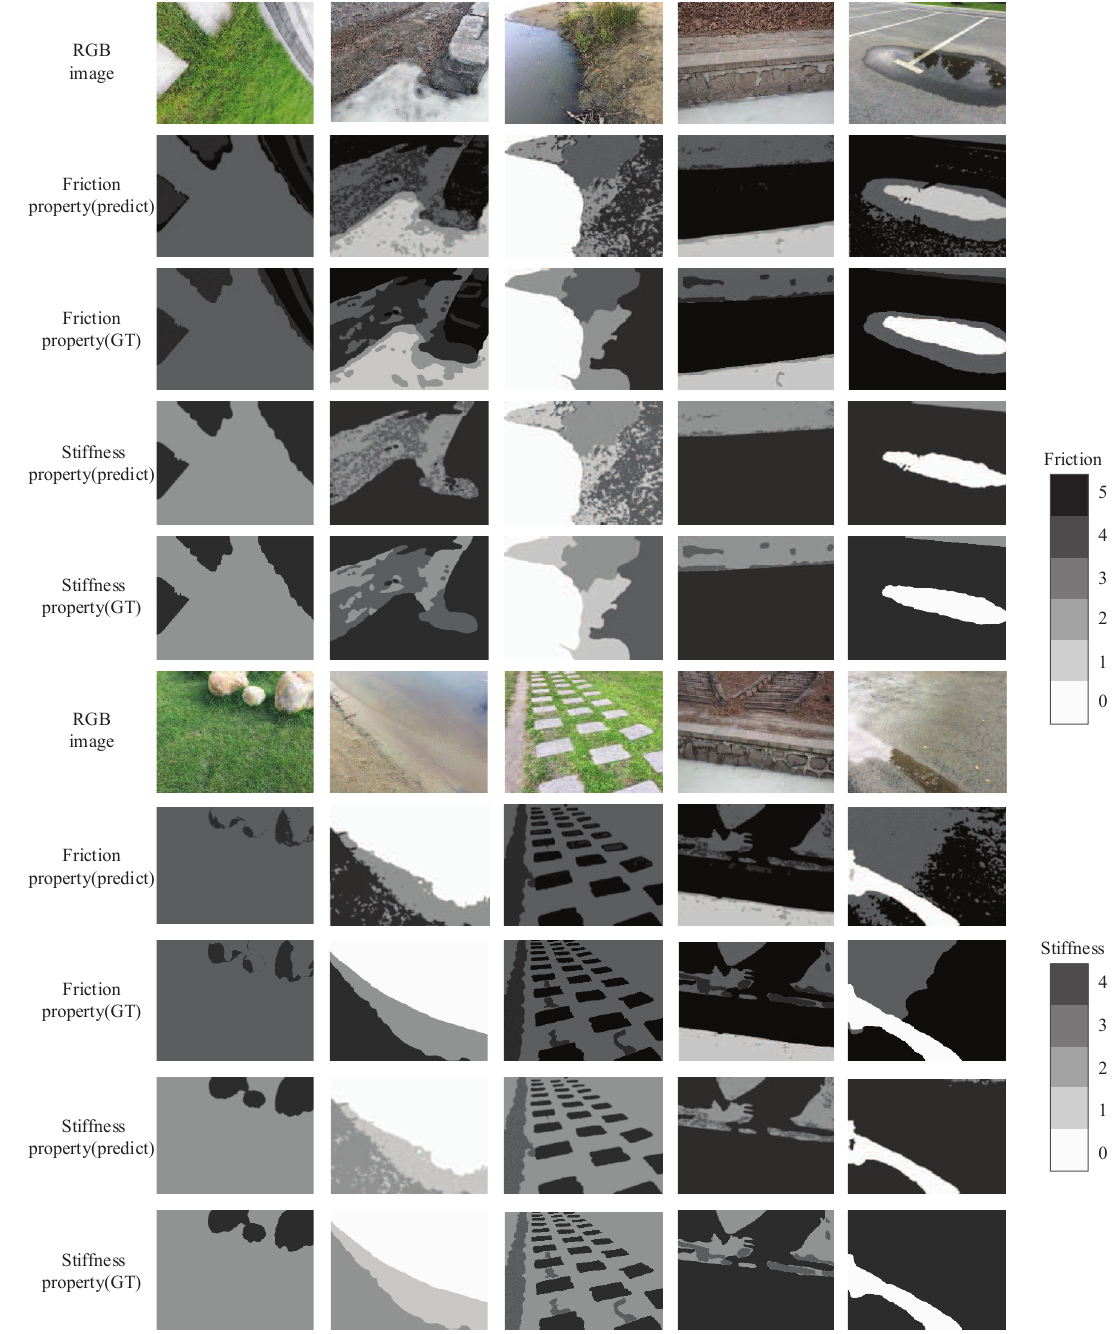
Figure 15. The experimental results of the complete framework proposed in this paper. The first and sixth rows are the input RGB images; the second and seventh rows are the inference results of friction property; the third and eighth rows are the ground truths of friction property; the fourth and ninth rows are the inference results of stiffness property; and the fifth and tenth rows are the ground truths of stiffness property. For better visualization, we mapped the inferential results of physical properties level to a more easily observed gray-scale image. The corresponding relationship between friction level and grayscale is shown in the rightmost column, and so is the stiffness